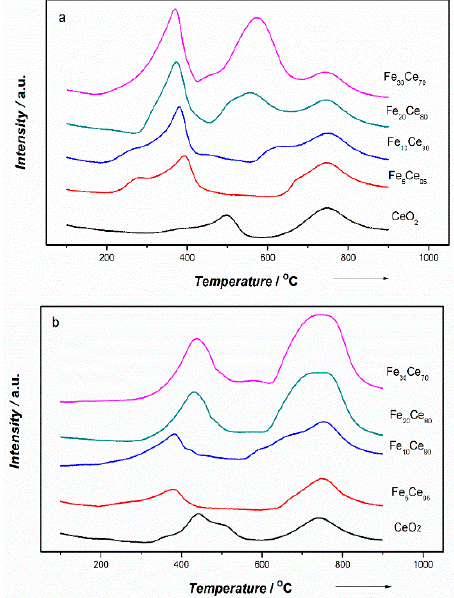
Figure6. Ramanspectraof( a )theco-precipitationmethod( b )thesolutioncombustionsynthesismethod. Figure 6. Raman spectra of ( a ) the co-precipitation method ( b ) the solution combustion synthesis method.